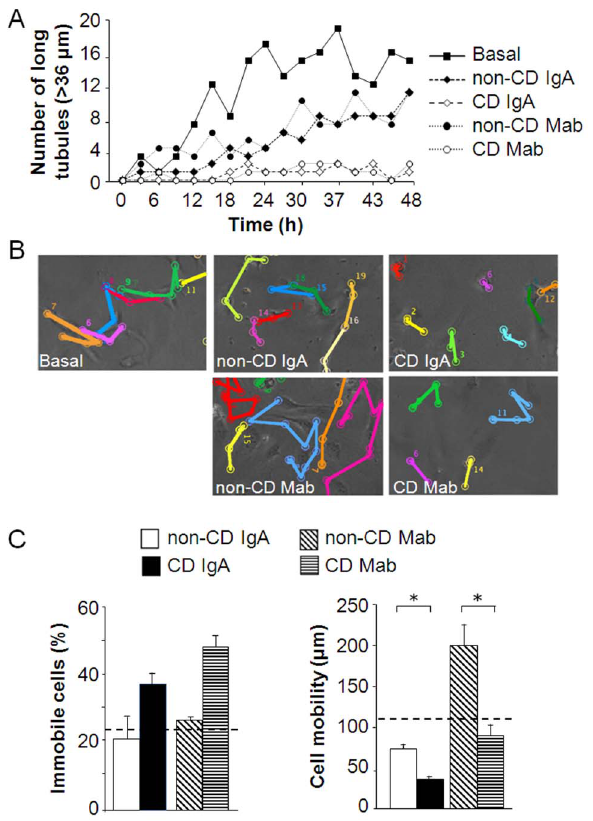
Figure 3. Endothelial cell dynamics in the presence of celiac patient-derived total IgA (CD IgA) or monoclonal antibodies (CD Mab), or their relevant controls (non-CD IgA or non-CD Mab). (A) The number of long tubules ( . 36 m m) was counted from videos taken from human umbilical vein endothelial cell (HUVEC) cultures during a 48 hour time course in the presence of CD IgA or CD Mab, or their relevant controls non-CD IgA or non-CD Mab. (B) HUVECs were tracked for 48 hours and cellular mobility during that time course is indicated in representative pictures. Each color represents an individual cell. (C) The percentage of immobile cells (left panel) and the cell mobility in micrometers (right panel) were determined in the cell cultures treated with CD IgA or CD Mab or their relevant controls. Bars represent the average value as percentage + SEM. Basal group is indicated as a dotted line. * represents P # 0.001 statistical difference.